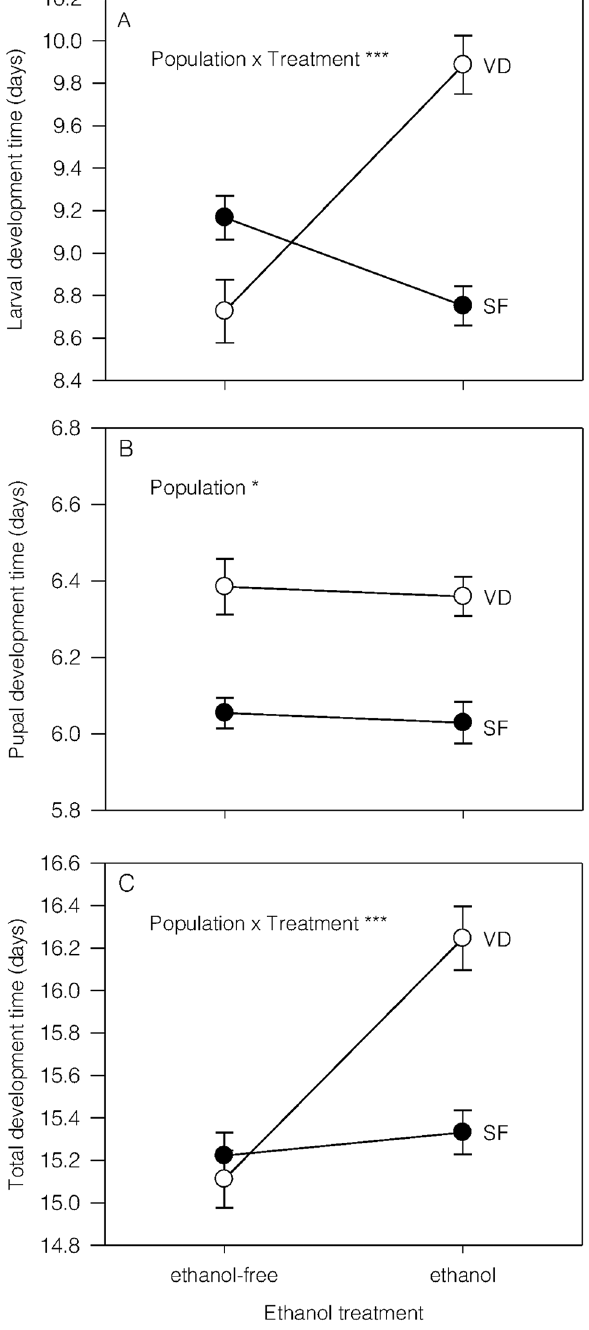
Figure 1. Reaction norms of development traits for Drosophila melanogaster flies developed in contrasting ethanol conditions. Average ( 6 SE) larval (A), pupal (B) and total (C) development time for flies (sexes were pooled) from the San Fernando (SF) and the Valdivia (VD) populations reared in ethanol-free (0% ethanol) and ethanol- supplemented (7% ethanol) conditions. Significant effects are expressed as: * P , 0.05, ** P , 0.01, *** P , 0.001.